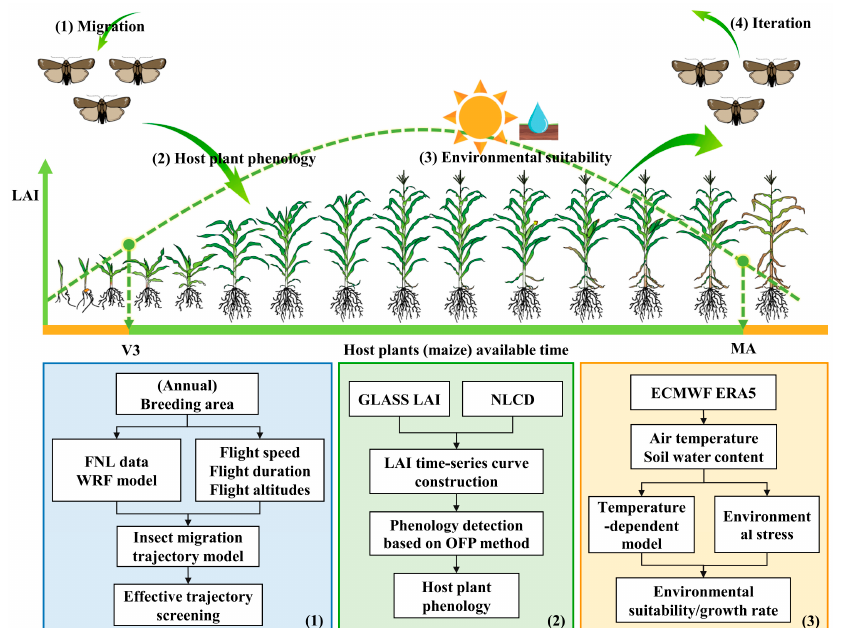
Figure 2. Methodological framework. Steps 1–4 in the upper part show a schematic representation of the FAW life cycle (described in the text). These steps are linked to the three modules presented in boxes in the lower part, which show the corresponding technical flow: (Box 1 ) Insect migration simulation module; (Box 2 ) Host plant phenology extraction module; (Box 3 ) Environmental suitability analysis module. A portion of the image materials is sourced from [46,47].